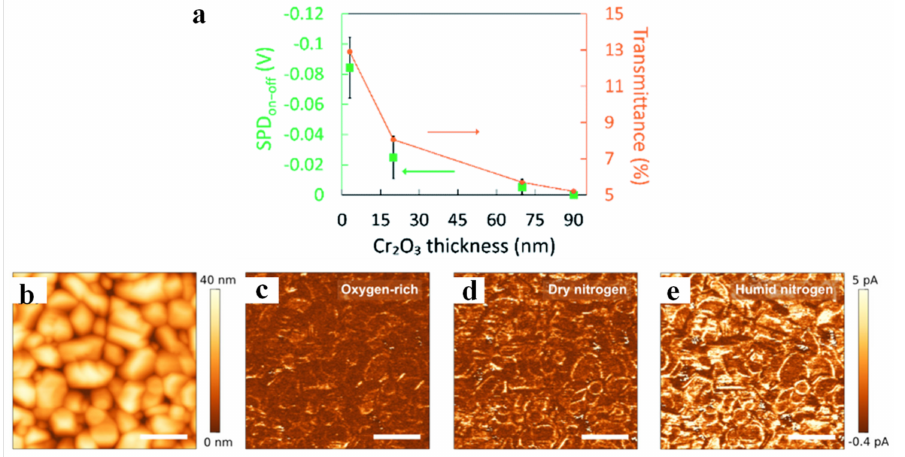
Figure 5. The change in the values between dark and 470 nm irradiations from the 3, 20, and 70 nm, as well as 90 nm Cr 2 O 3 film, including their transmittance ( a ). Adapted with permission from ref. [87]. Copyright 2022 The Royal Society of Chemistry. Topography ( b ) and current images under illumination (V s = 1.75 V) in oxygen ( c ), dry ( d ), and humid ( e ) nitrogen atmosphere measured at identical areas. Adapted with permission from ref. [26]. Copyright 2018 American Chemical